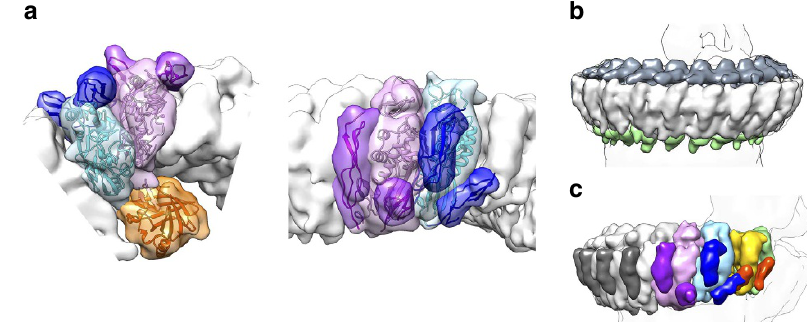
Figure 2 | Molecular architecture of the complex. ( a ) Top (left panel) and side (right panel) views of the CDC/MACPF rim zoomed in, to show fitting of C8 a (purple), C8 b (blue) and C8 g (orange) into the MAC reconstruction (transparent surface). ( b ) Arrangement of LR (dark grey) and EGF (green) domains around the rim. ( c ) Density for the MAC segmented and coloured according to subunit composition: C6 (green), C7 (yellow), C8 (coloured as in a ) and C9 (grey). TS domains for each protein are indicated by darker shades. Silhouette of the unsharpened map is shown for